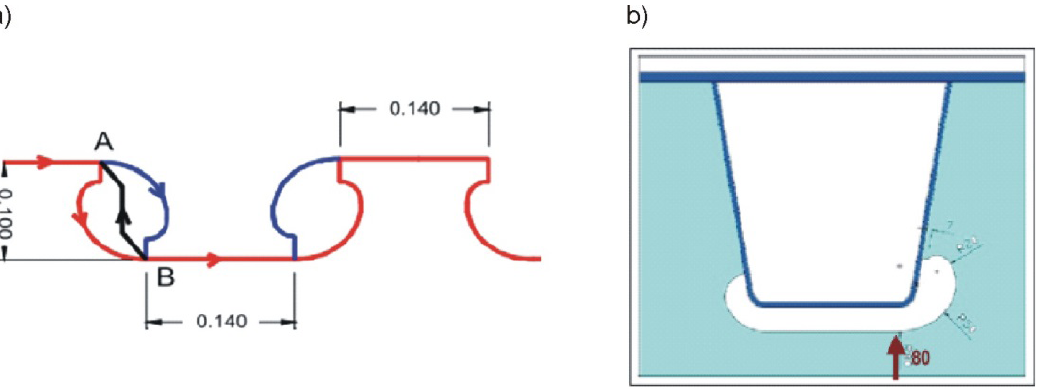
Figure 29: Clothoidal shape (CL) by Berthellemy: a) idea for geometry and cutting line, b) structural solution for an orthotropic deck as the basis for the geometry and dimensions.